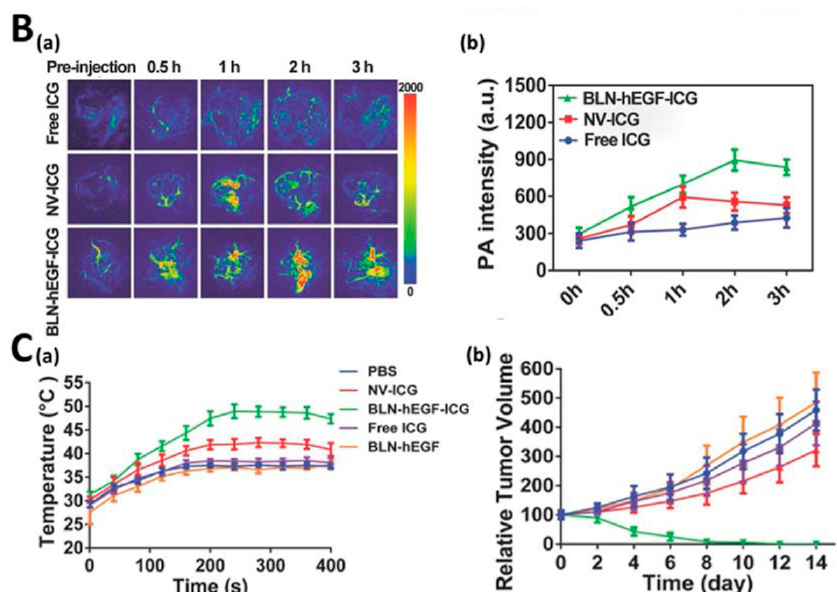
Figure 1. Biofunctionalized liposome-like nanovesicle (BLN) for active cellular targeting. ( A ) General scheme. ( a ) Plasmids containing ligands for targeted cell-surface marker protein human epidermal growth factor (hEGF) were genetically engineered and then transfected into the cells to express the modified targeting ligands on the cell surface. ( b ) Expressed protein ligands were further transported to the Golgi body via a signal peptide-mediated protein trafficking route. ( c ) Transport vesicles carrying ligands from the Golgi body fused with the plasma membrane, thus presenting targeting proteins on the cellular surface. ( d ) With sodium deoxycholate entrapped in the plasma membrane bilayer, ligand-presenting giant plasma membrane vesicles begin to bud from the cell surface in a manner similar to the secretion process of exosomes. ( e ) After incubation of giant plasma membrane vesicles with drugs and surfactants, ultrasonic vibration encapsulates the drug indocyanine green (ICG) into uniform nanoscaled BLNs. ( f ) Drug-loaded BLN-hEGF exhibit ligand-mediated affinity to EGF receptors on the tumor surface. ( B ) In vivo photoacoustic (PA) images ( a ) and average PA intensity ( b ) of nude mice with MDA-MB-468 tumors after intravenous administration of BLN–hEGF–ICG, nanovesicles without targeting ligands (NV-ICG), or free ICG (Free-ICG) at time points indicated. Image intensities are shown in color scale on the right. ( C ) Increasing temperature profiles ( a ) of the tumor regions 2 h after intravenous administration of different formulations under 808 nm laser irradiation (1 W cm − 2 for 10 min). Relative tumor volume changes ( b ) in different treatment groups after phototherapy. Figure reproduced from [43] with permission from WILEY-VCH, 2017.